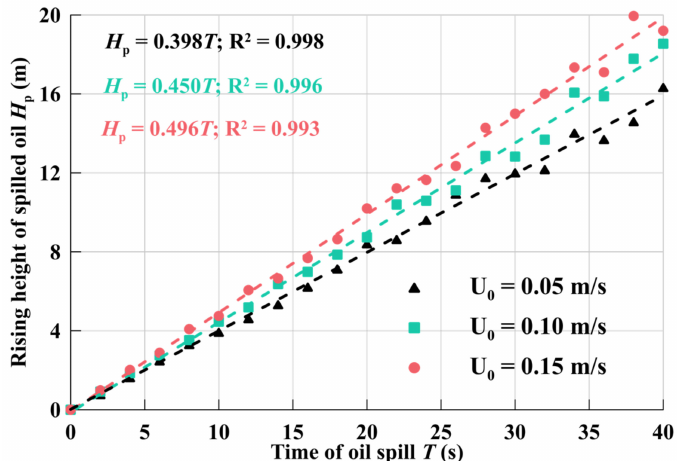
Figure 8. Rising height of spilled oil for three different maximum ocean current velocities. ( U P = 0.10 m/s).